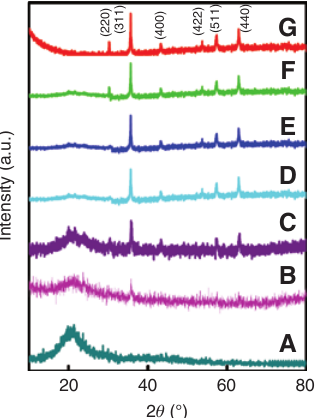
Figure 2: XRD pattern of (A) pure blend (B) blend + 0.5 wt% Fe O nanoparticle (C) blend + 1 wt% Fe 2 3 blend + 1.5 wt% Fe nanoparticle (F) blend + 2.5 wt% Fe nanoparticle.